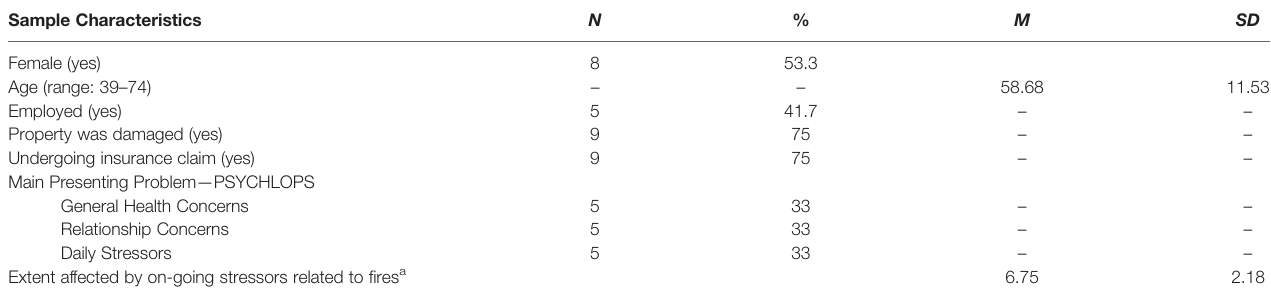
TABLE 2 | Pilot sample characteristics (n =